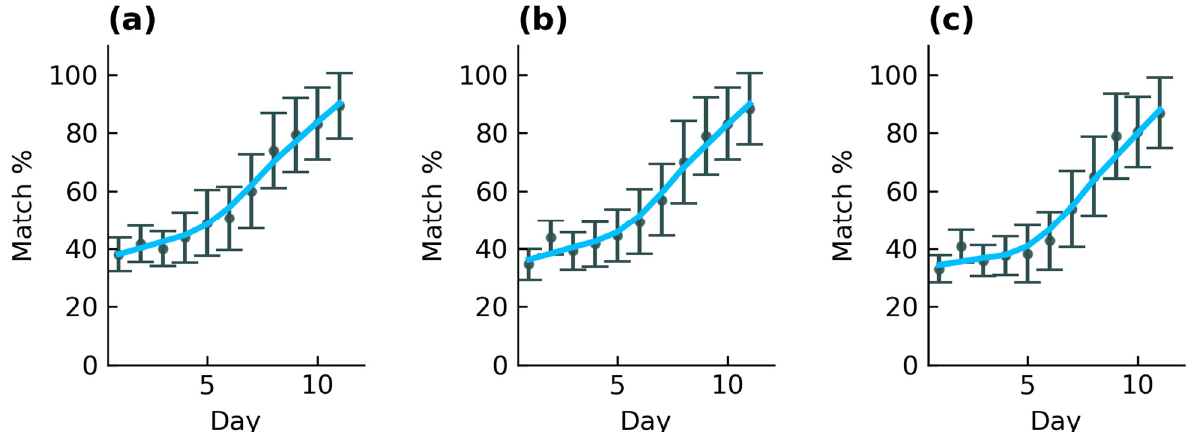
Figure 7. Match percentage between heatwave days and LST anomalies as a function of the number of days since the start of an episode during daytime for ( a ) MXD_P85_D3, ( b ) MXD_P90_D2, and ( c ) MXD_P95_D1; blue curves correspond to the lowess regression lines; error bars correspond to half standard deviation.